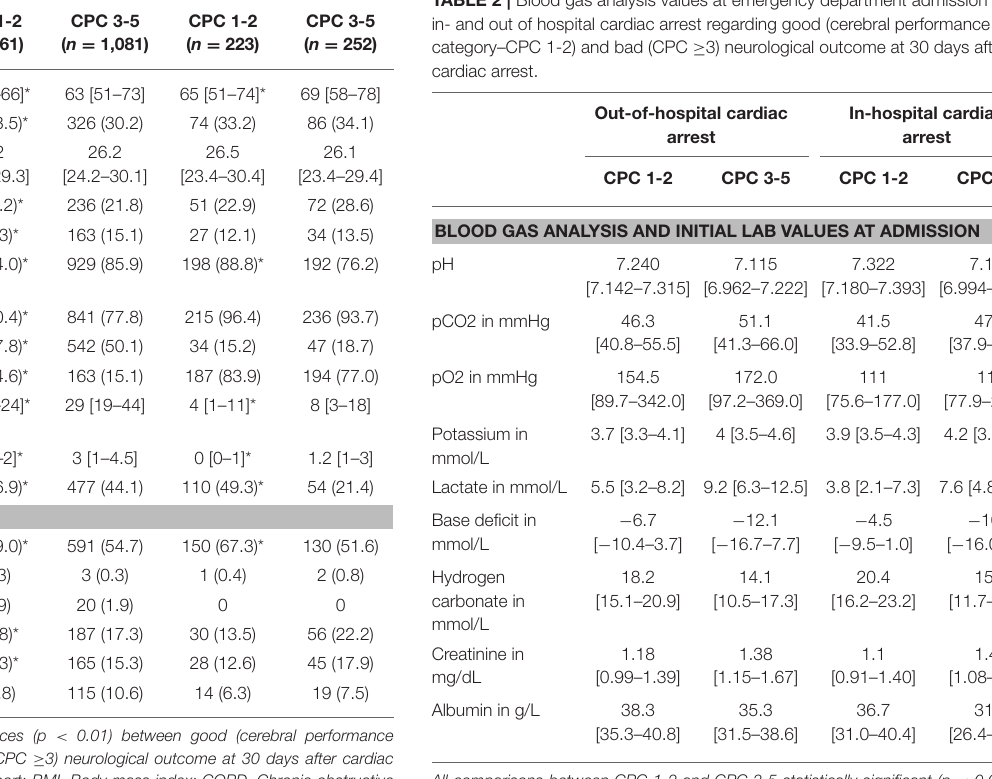
TABLE 2 | Blood gas analysis values at emergency department admission after in- and out of hospital cardiac arrest regarding good (cerebral